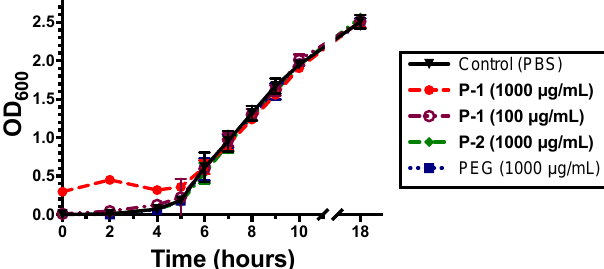
Figure 3. Effect of polymers on planktonic P. aeruginosa growth behavior in tryptic soy broth (TSB) with orbital shaking in the presence of P-1, P-2 or PEG. The data points and error bars represent the average and standard deviation from three independent experiments ( n = 3). The data points at the time of 0 were taken immediately after the addition of the polymers.